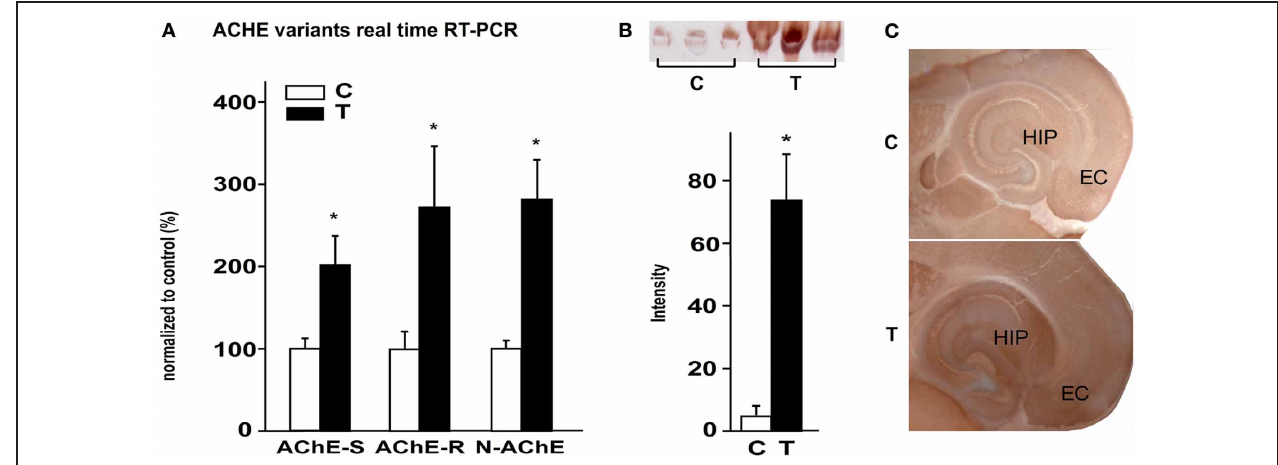
non-denatured activity gel of control and 48h after SE samples. Bottom: gel quantification ( p = 0.05; n = 3; mean ± SEM; Mann–Whitney test). (C) Karnovsky–Roots staining of 200 μ m horizontal brain sections from control and 48h post SE mice. C, control; T,